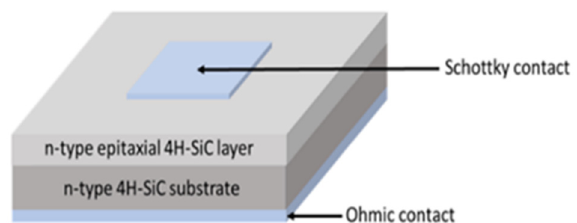
Figure 1. A schematic cross-section of a typical n-type 4H-SiC Schottky barrier diode (SBD). SBD is formed when a metal and an n-type semiconductor are joined. Due to band alignment, a depletion space charge region (a volume depleted of charge carriers) is created at the semiconductor side of the junction [5]. As we apply the external bias, we enable the transport of electrons, and a net current will flow through the SBD. The SBD is reversely biased when a negative voltage (V R ) is applied to the metal with respect to the semiconductor. The SBD is kept under reverse bias when junction transient spectroscopies are applied.